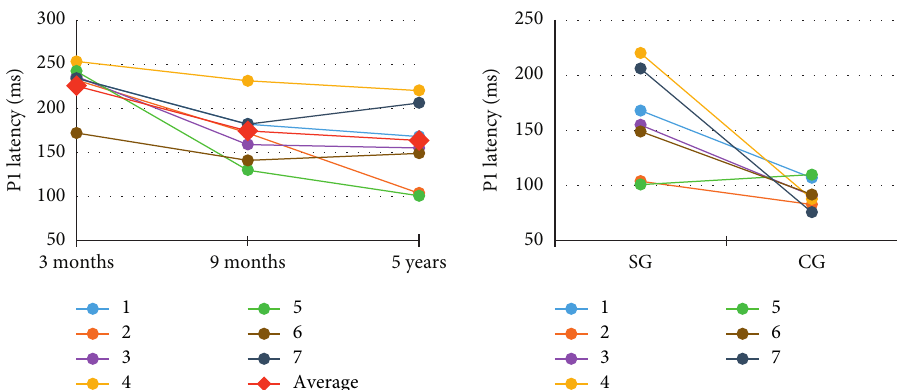
Figure 2: Individual SG profiles of progression of the P1 latency and comparison of results obtained between SG and CG in the last